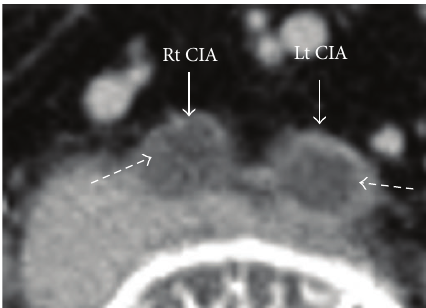
Figure 3: CT showed that the bilateral common iliac arteries were occluded with thrombus. The high density area was observed in low density area (dotted arrows).